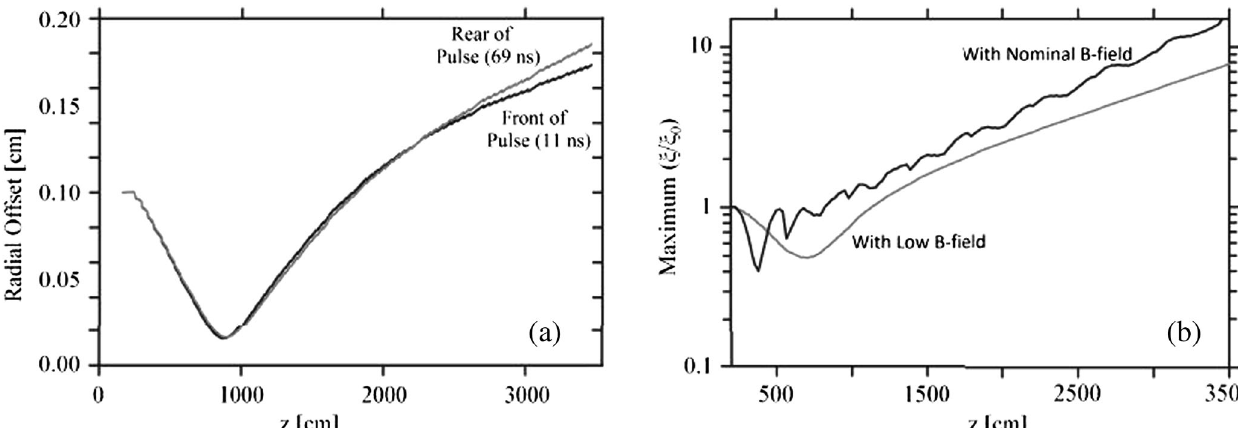
FIG. 4. LAMDA Code Calculations: (A) — The resistive wall instability and centroid displacement due to image currents and image charges in continuous parts of the accelerator lead to a final centroid displacement of 2 mm and a relative head to tail displacement of 0.1 mm, both for an initial 1 mm centroid offset. (B) — The growth rate of the BBU instability for the IDI tune is lower than that of the nominal tune of Axis I.